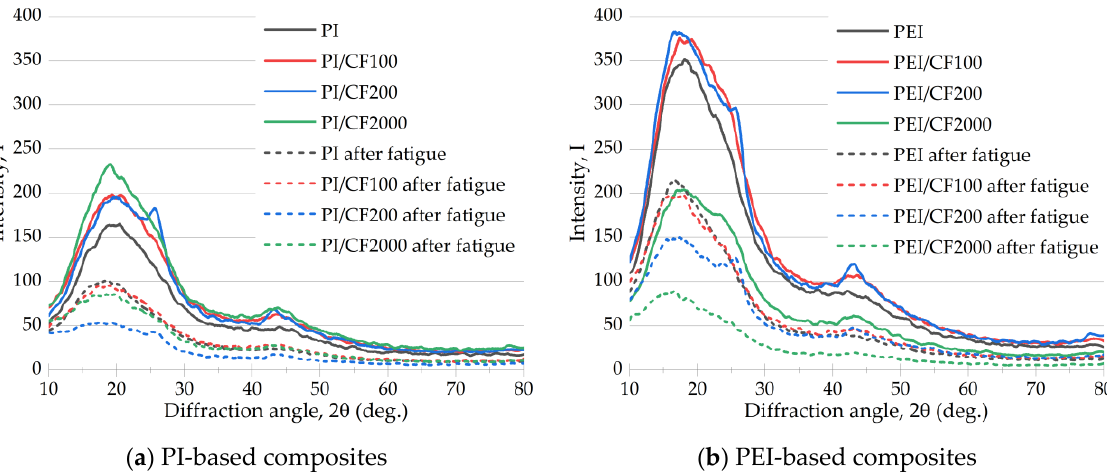
Figure 13. The X-ray diffraction (XRD) spectra of the PI- ( a ) and PEI-based ( b ) composites before and after the fatigue tests.